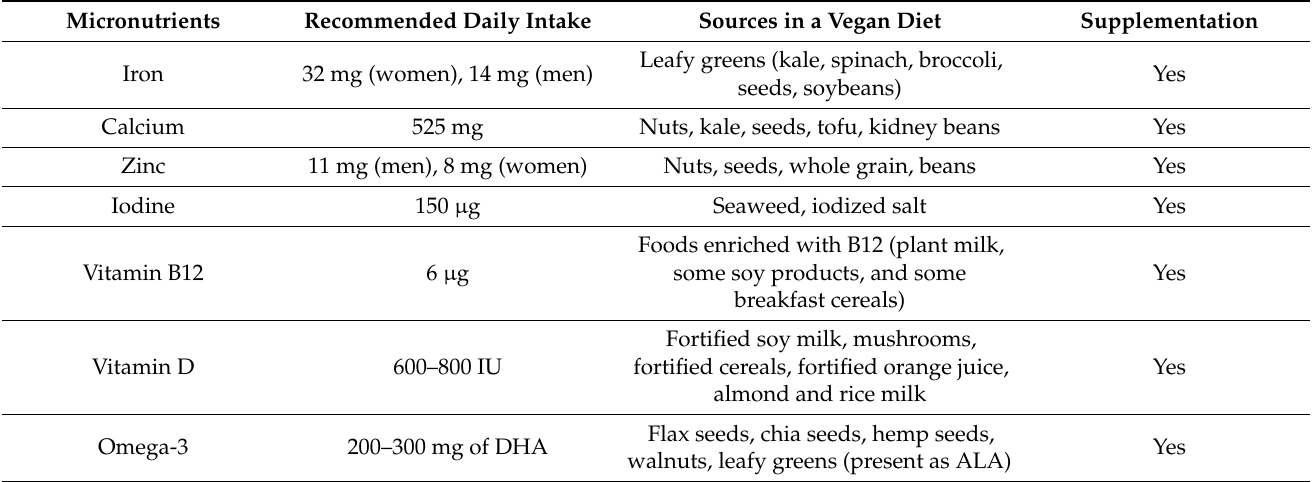
Table 1. Summarized daily intake and supplementation of vitamins and minerals in a vegan